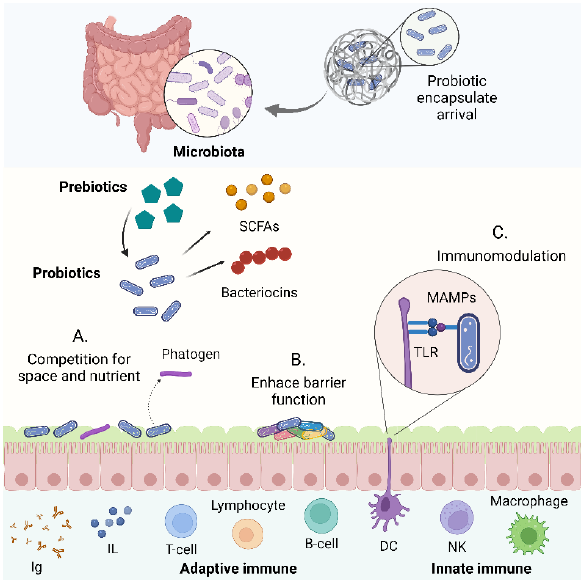
Figure 3. Beneficial interactions of encapsulated probiotics with gut microbiota can be classified according to three different mechanisms: ( A ) Nutrient and space competition with other microor- ganisms present in the site of action (i.e., pathogens), ( B ) strengthening of the mucosal barriers, and ( C ) modulating and stimulating immunological responses of the host. Probiotics also can secrete metabolites as SCFAs or bactericidal molecules (Created with BioRender.com accessed on 1 February